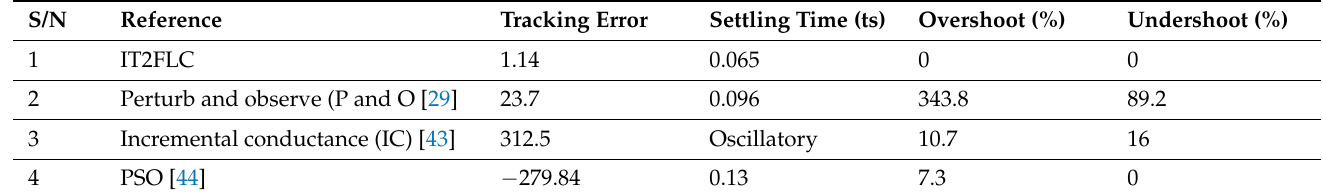
Figure 26. Power response of all four methods. Table 5. Power Response Comparison between